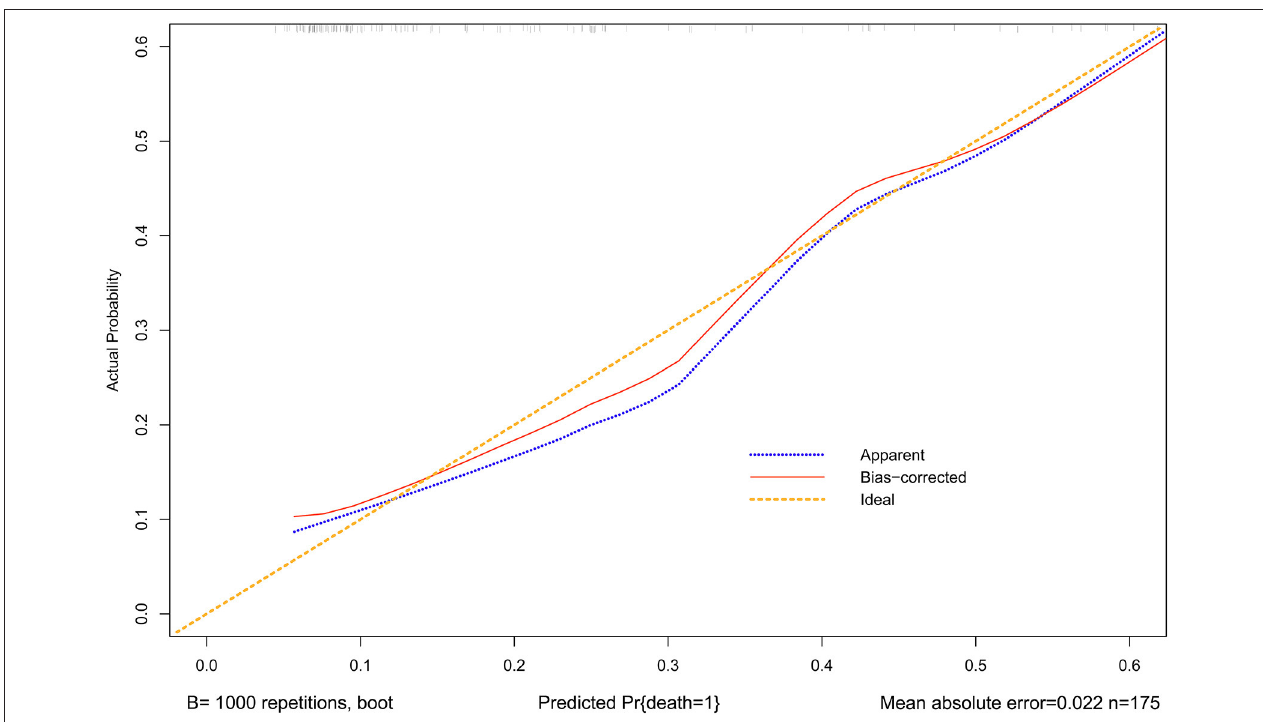
FIGURE 5 | Calibration curves for the nomogram. The x -axis represents the nomogram-predicted probability, and the y -axis represents the actual probability of the nomogram. A perfect prediction would correspond to the 45 ◦ yellow dashed line. The blue dotted line represents the entire cohort ( n = 175), and the red solid line is bias-corrected by bootstrapping (B = 1,000 repetitions), indicating observed nomogram performance. The mean absolute error = 0.022